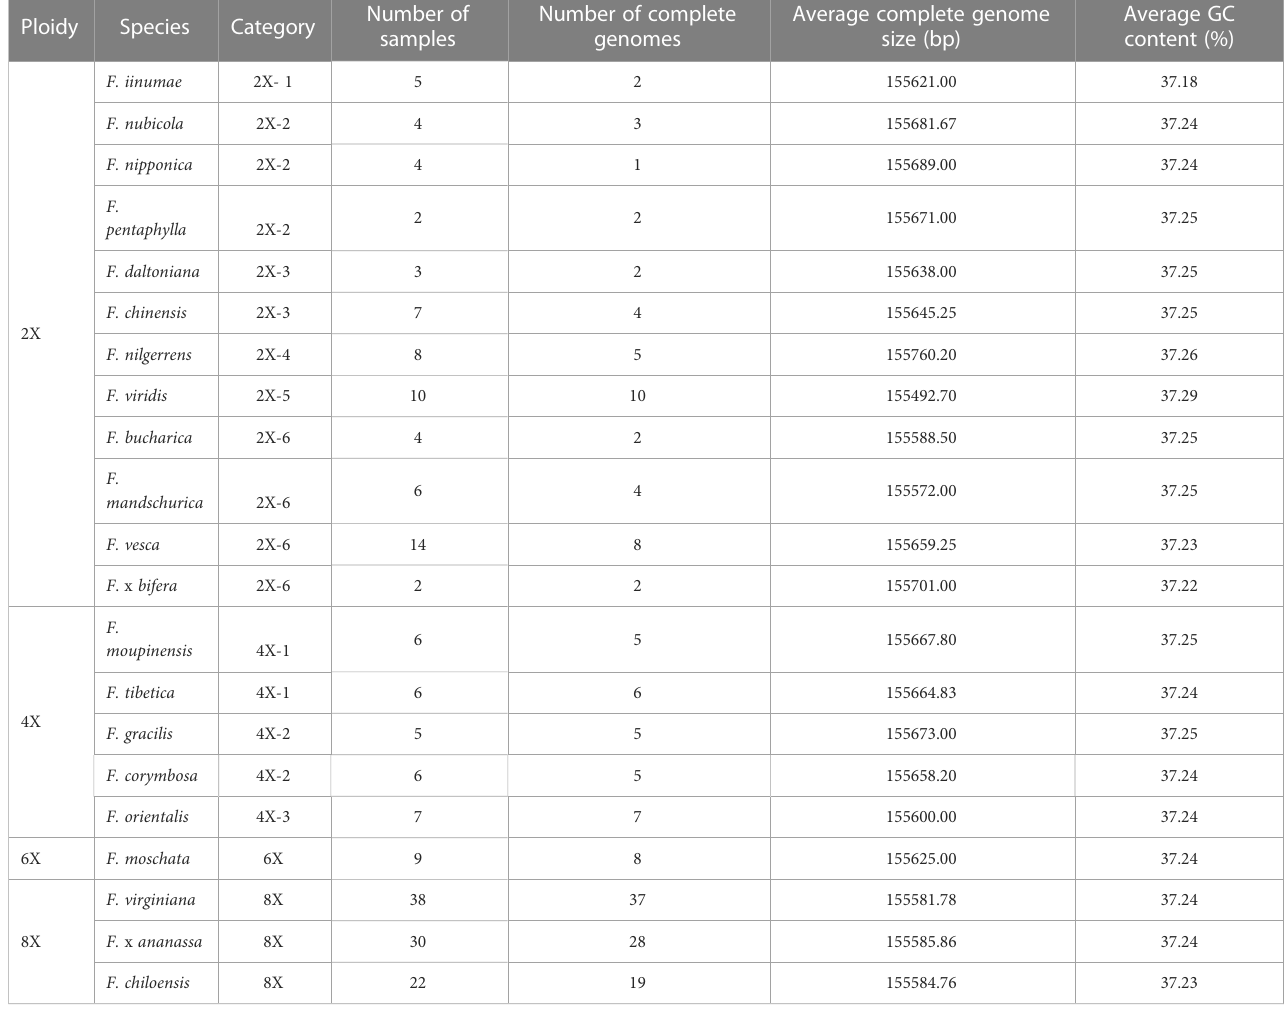
TABLE 1 Chloroplast genome features of 22 Fragaria species (21 wild species and 1 cultivated strawberry).